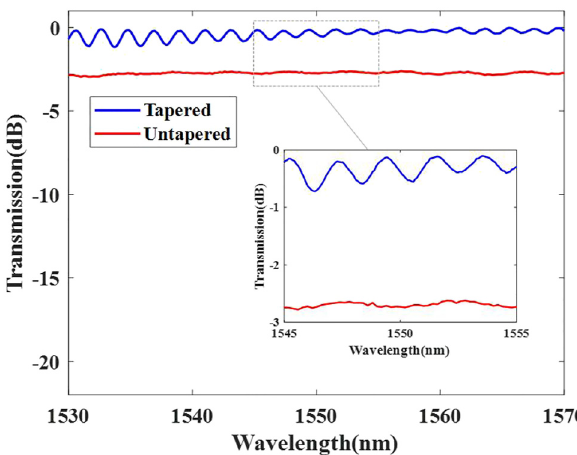
Figure 7: Transmission loss of the tapered and untapered fibers.